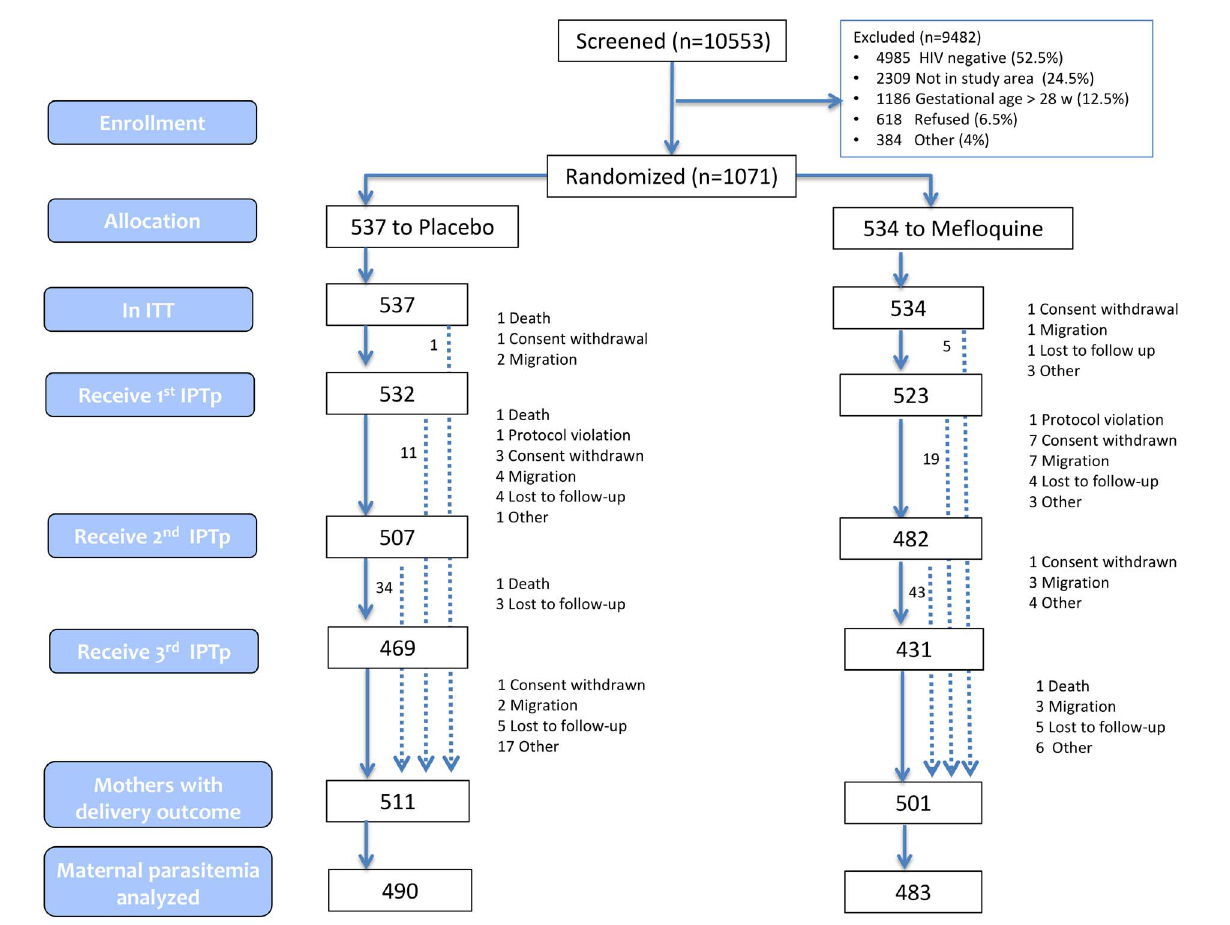
Figure 1. Trial profile (ITT cohort).